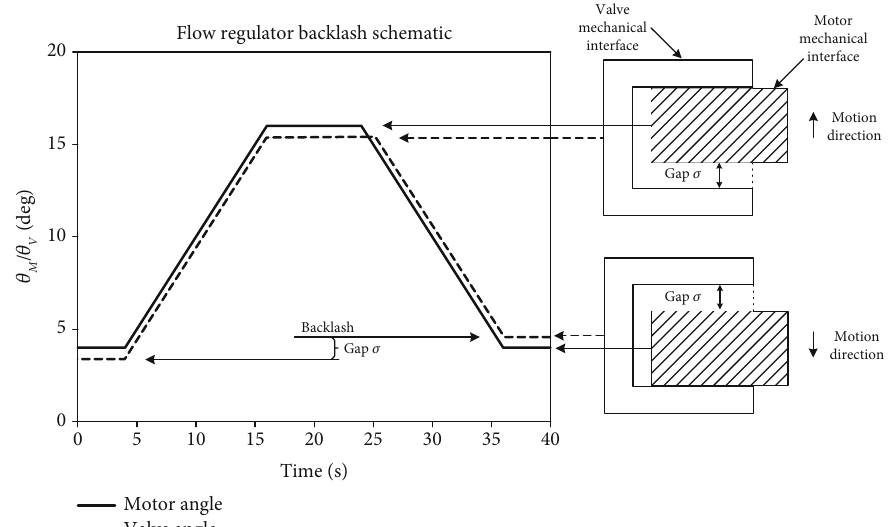
Figure 5: Schematic representation of fl ow regulator backlash.